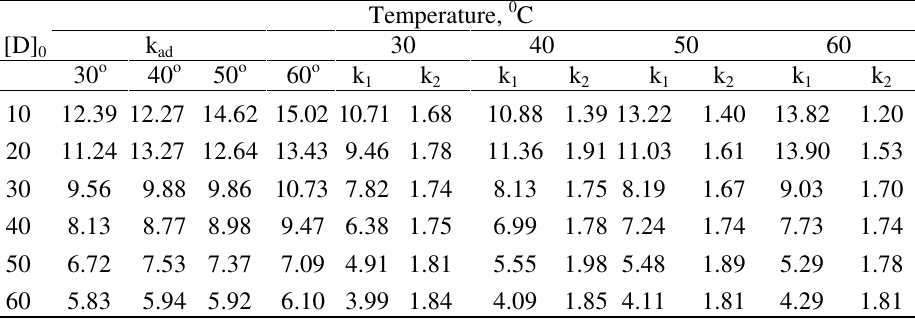
, min -1 ) and the constants ad